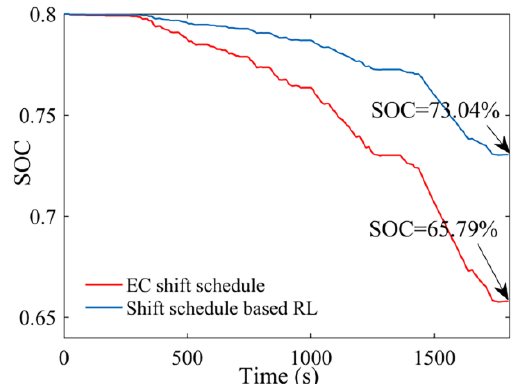
Figure 17. SOC result comparison.